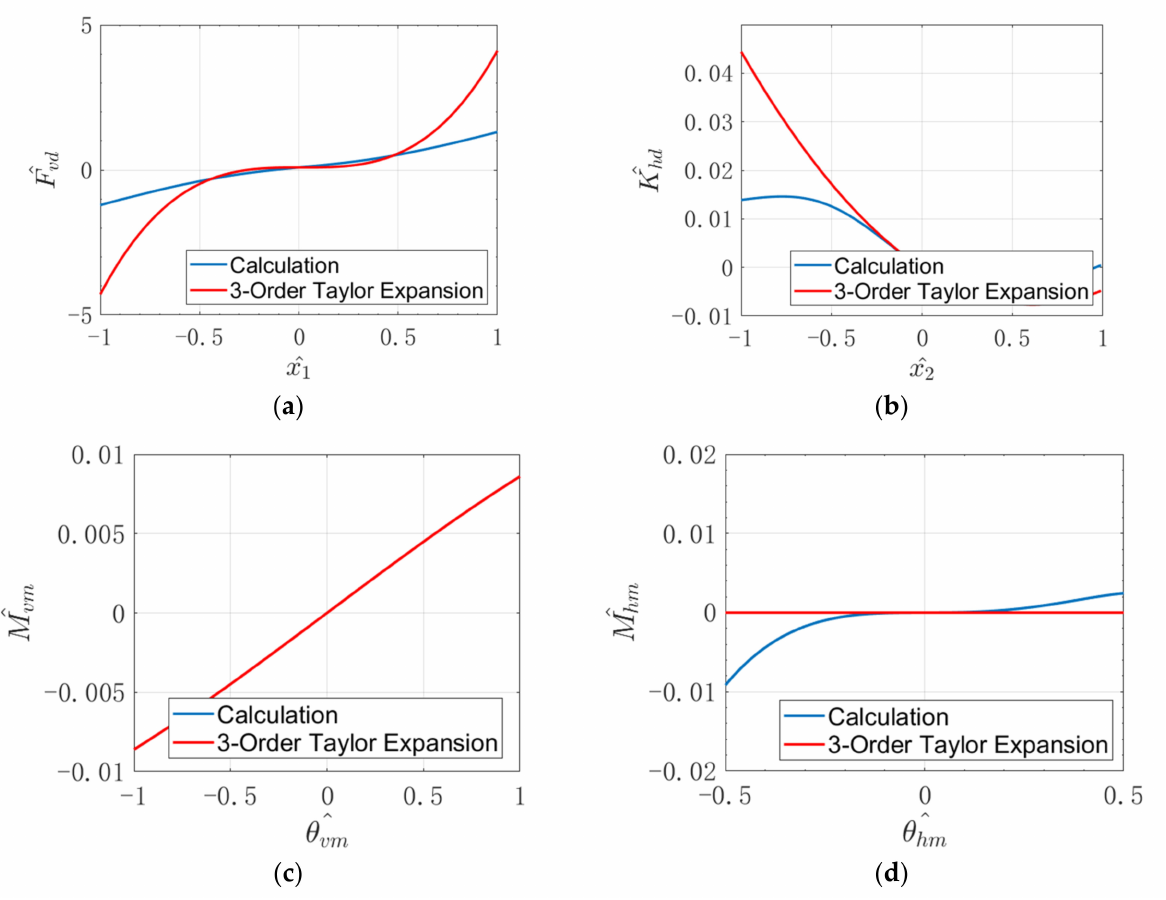
Figure 10. Comparisons of force-displacement curves: ( a ) vertical displacement; ( b ) horizontal displacement; ( c ) vertical rotation; ( d ) horizontal